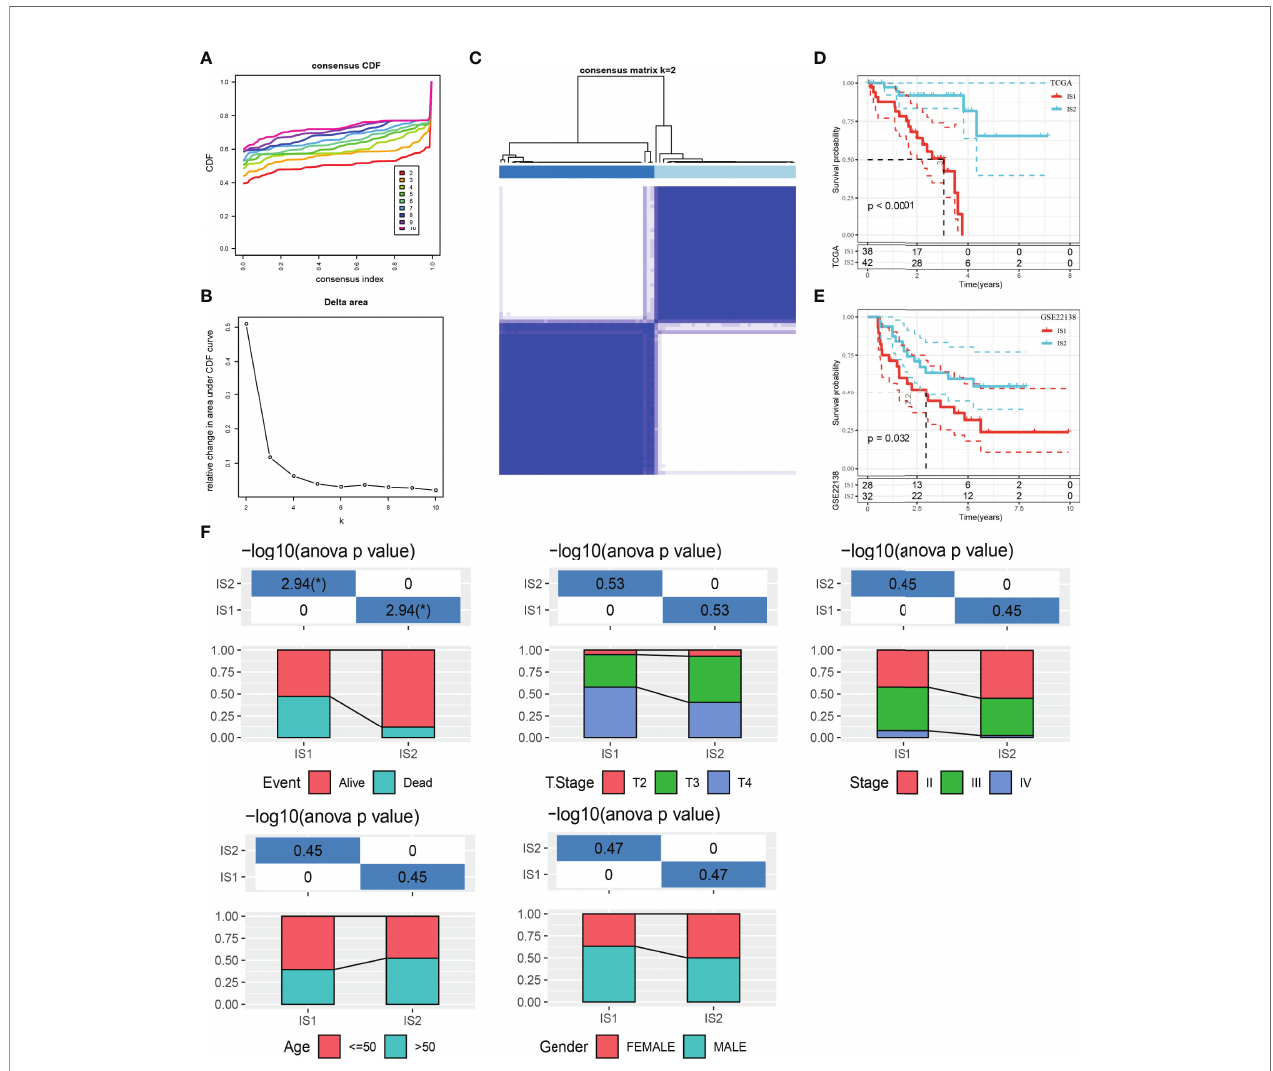
FIGURE 1 | The relationship between classi fi cation of UM patients based on prognostic immune gene sets and different clinicopathological features. (A) CDF curves of the consensus score. (B) Relative change in area under the CDF curve. (C) Consensus clustering matrix for k = 2. (D) Survival analysis of IS1 ( n = 38) and IS2 ( n = 42) in the TCGA dataset. (E) Survival analysis of IS1 ( n = 28) and IS2 ( n = 32) in the GSE22138 dataset. (F) Clinicopathological characteristics of two ISs in the TCGA dataset, including age, gender, T stage, TNM stage, and survival status. * p < 0.05. CDF, cumulative distribution